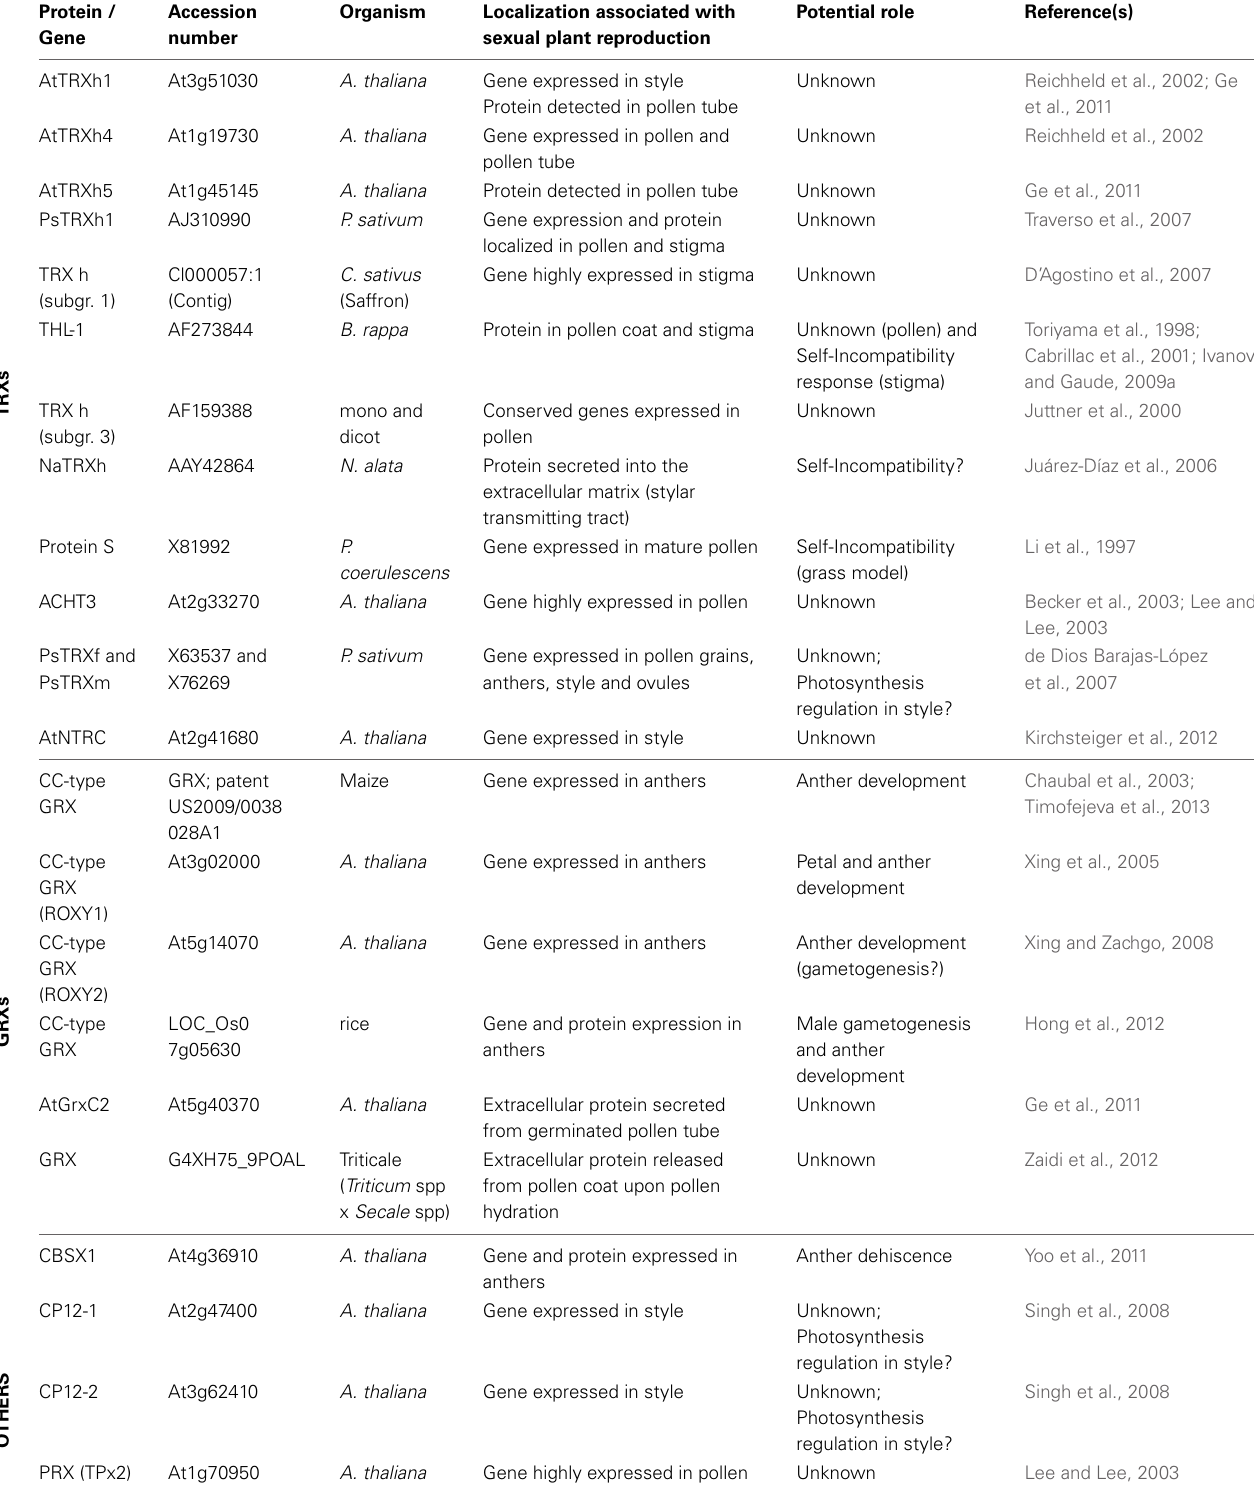
Table 1 | Described redoxins and other related proteins involved in sexual plant reproduction. Protein